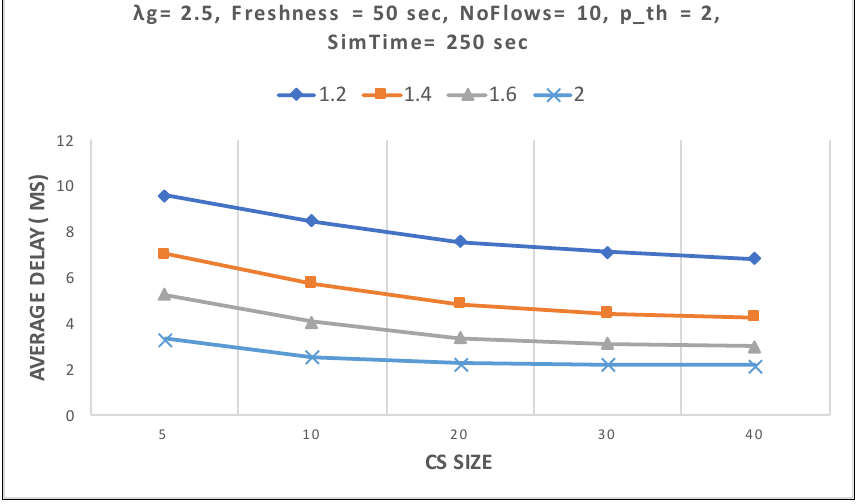
Figure 7. Content average delay as a function of CS size and Zipf